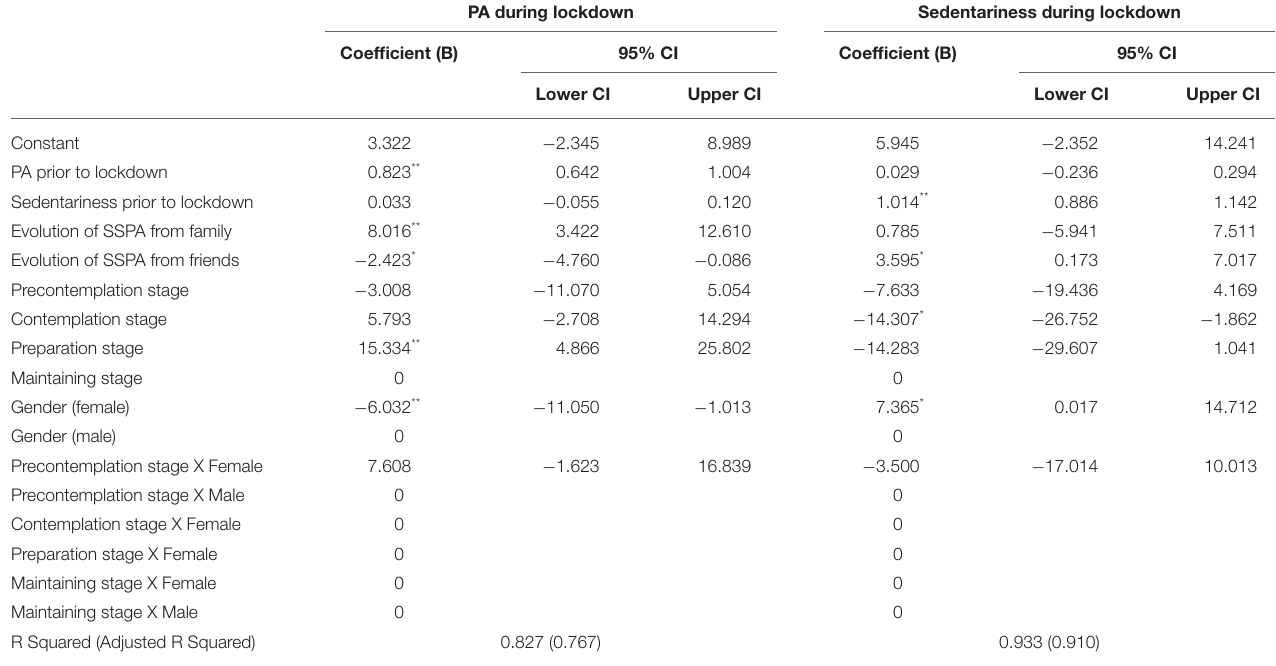
TABLE 9 | General linear model for retirees ( n =